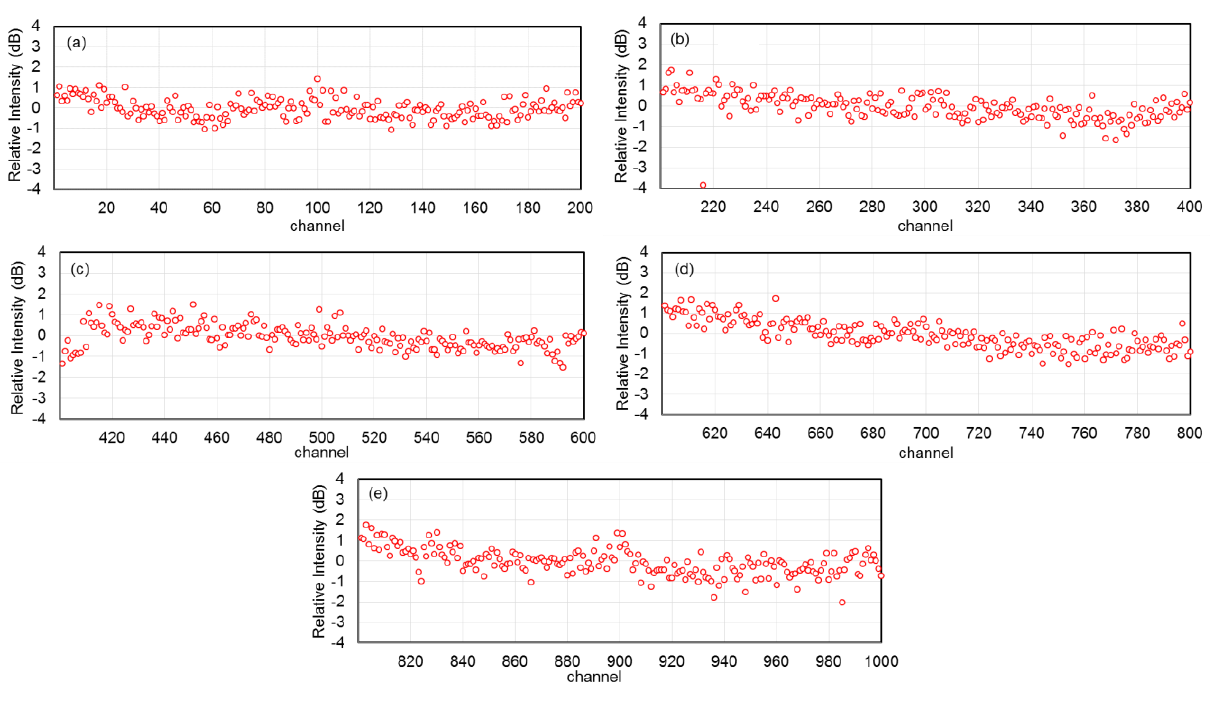
Figure 4. Relative intensity of 200 output ports at ( a ) first LD array; ( b ) second LD array; ( c ) third LD array; ( d ) fourth LD array; ( e ) fifth LD